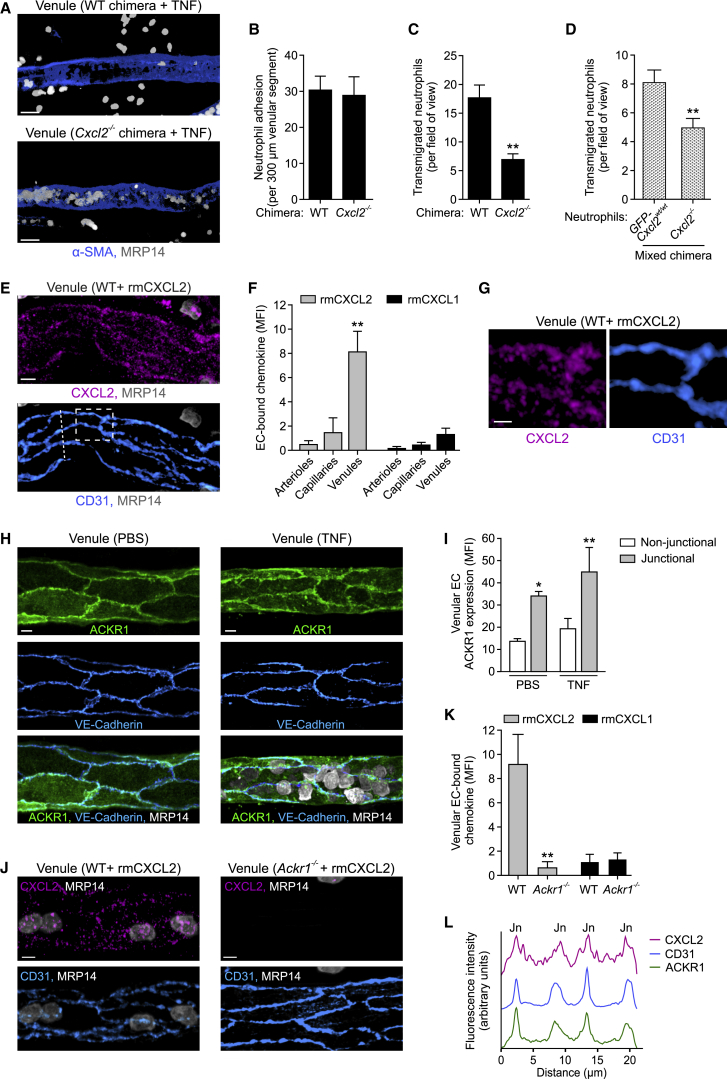
CXCL2 Mediates Neutrophil TEM in a Cell-Autonomous Manner and Is Retained at EC Junctions via the Atypical Chemokine Receptor ACKR1(A–C) Representative confocal images of venules in TNF-stimulated cremaster muscles of control (WT) or leukocyte CXCL2-deficient (Cxcl2−/−) chimeras stained for α-SMA and MRP14 (A) and associated quantifications of neutrophil adhesion and extravasation (B, C; n = 4 mice per group) from 4 independent experiments). Scale bars, 30 μm.(D) Numbers of extravasated GFP-Cxcl2wt/wt and Cxcl2−/− neutrophils in TNF-stimulated cremaster muscles of mixed chimeras, as normalized for neutrophil numbers in the blood (n = 4 mice, 3 independent experiments).(E–G) RmCXCL2 or rmCXCL1 was injected i.s. into WT mice and cremaster muscles were stained for CXCL2 or CXCL1, CD31, and MRP14 and analyzed by confocal microscopy. Images (E; representative of 4 independent experiments; scale bar, 5 μm), quantified localization of rmCXCL2 or rmCXCL1 within the microcirculation (F, n = 3–8 mice per group, 8 independent experiments), and enlarged images of the boxed region in (E) (G; scale bar, 2 μm).(H and I) Cremaster muscles were stimulated with PBS or TNF and IF stained for ACKR1, VE-Cadherin, and MRP14. Confocal images of venules (H; scale bars, 5 μm) and quantification of ACKR1 localization (I, n = 4 mice per group, 4 independent experiments).(J–L) IF localization of rmCXCL2 and rmCXCL1 in cremasteric venules in relation to ACKR1 expression. Representative confocal images of tissues from WT and Ackr1−/− mice injected with rmCXCL2 (J; scale bars, 5 μm) and quantifications of endothelial rmCXCL2 and rmCXCL1 binding (K, n = 4–5 mice per group, 3 independent experiments). (L) CXCL2, ACKR1, and CD31 IF intensities along the dashed line in (E) cutting across 4 EC junctions (Jn; representative of 4 independent experiments). Means ± SEM, ∗p < 0.05, ∗∗p < 0.01 (as compared to arterioles or capillaries in F and non-junctional ACKR1 expression in I).See also Figure S5.